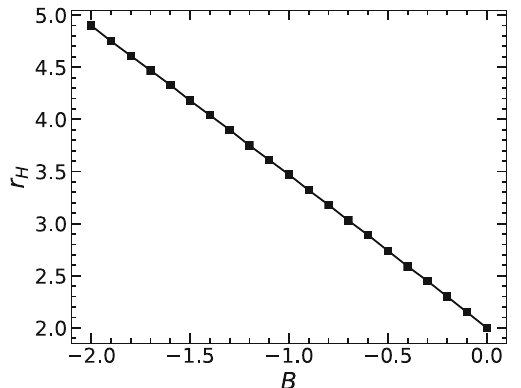
Fig. 3 The variation of event horizon r H as a function of B . All the quantities are expressed in dimensionless units, which is considered with c = G = M = 1